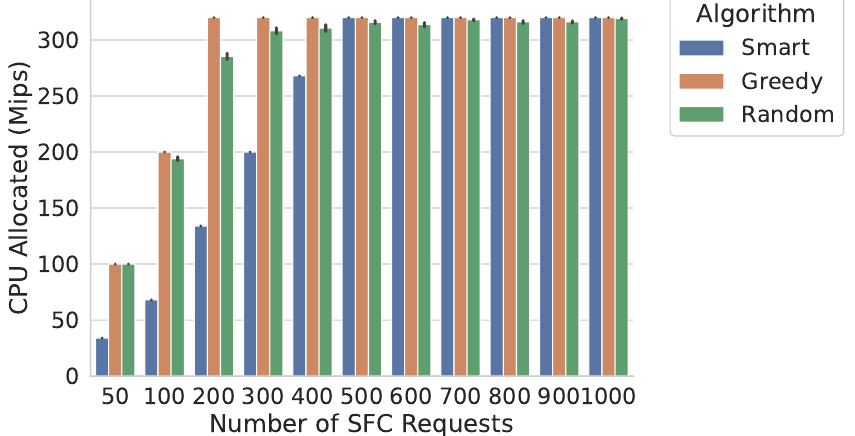
Figure 9. Allocated CPU resources.